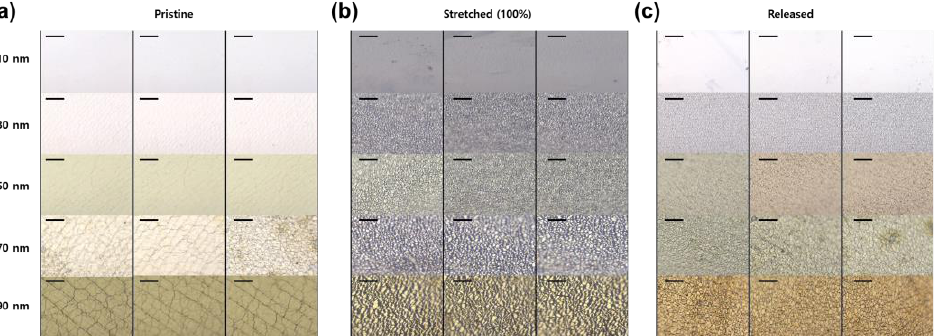
Figure 3. Optical images of the Au nanomembranes. ( a ) Pristine, ( b ) 100% stretched by a motorized X-translation stage, and ( c ) released after stretching (s cale bar: 20 μm) .